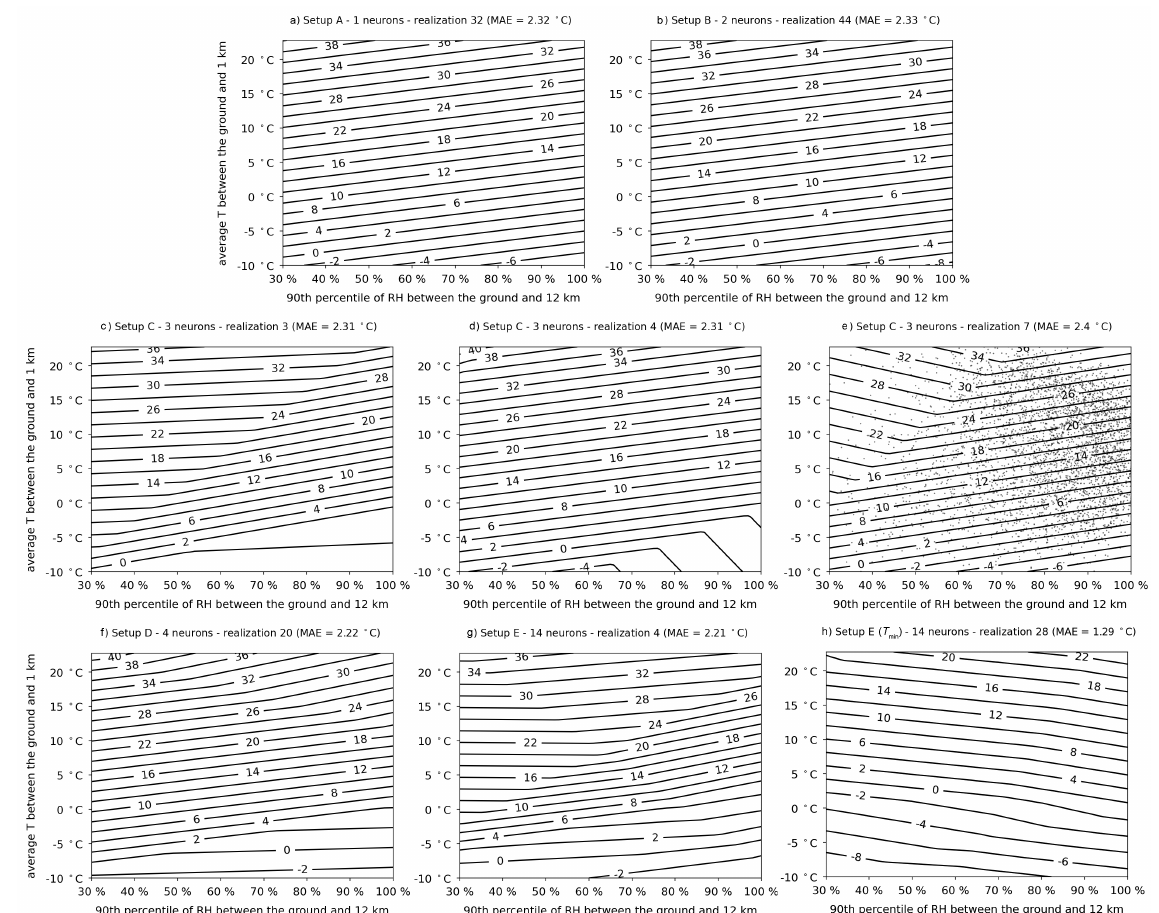
Figure 4. Analysis of minimalist NNs listed in Table 1. The contours represent the forecasted values of either T max ( a – g ) or T min ( h ), which depend on two input parameters (the average temperature in the lowest 1 km and the 90th percentile of RH). ( e ) Also shows the values of the 3800 sets of input parameters that were used for the training, validation and testing of NNs (gray